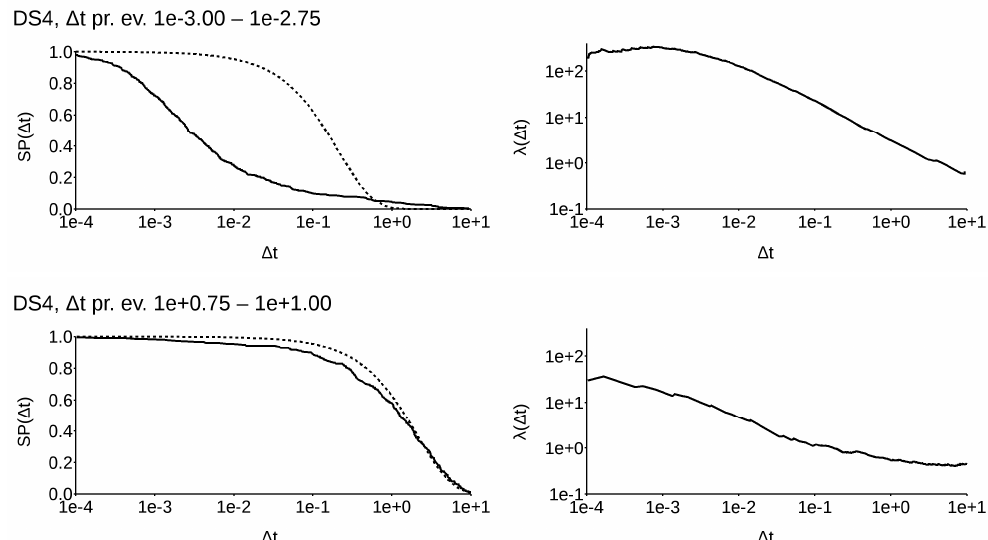
Figure 6. Survival probability ( left ) and λ ( ∆ t ) ( right ) for DS4 along the narrow bands, selected as in Figure 4. Solid lines refer to empirical functions, while dashed lines refer to Poissonian ones.